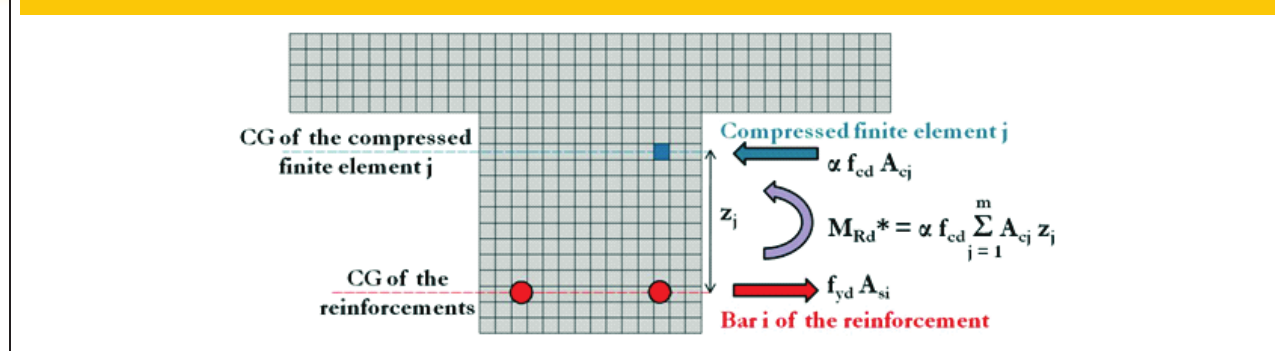
Figure 5 – Equilibrium of forces in a reinforced concrete section at room temperature